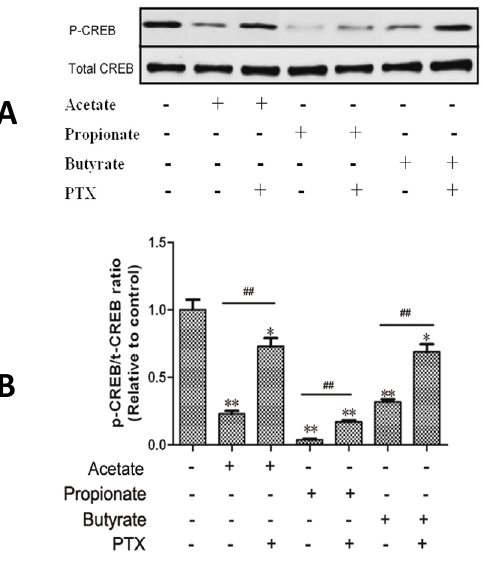
Figure 4. The effect of SCFAs on the CREB phosphorylation in DCAPCs. The cells were treated with or without prior PTX incubation (100 ng/L) for 2 h, and then stimulated with 1.0 mmol/L acetate, propionate, or butyrate for 6 h, respectively. Each treatment